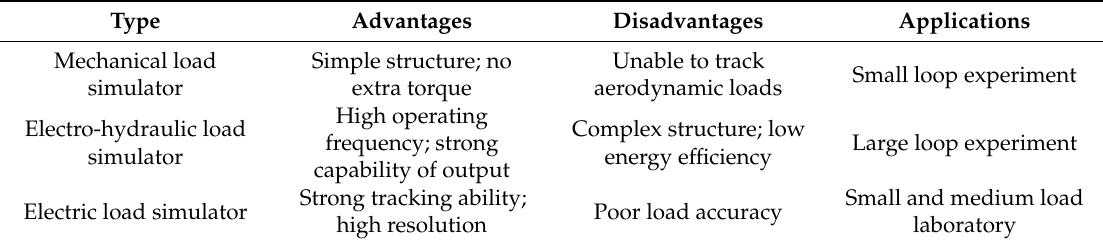
Table 1. Comparisons of different load simulators.